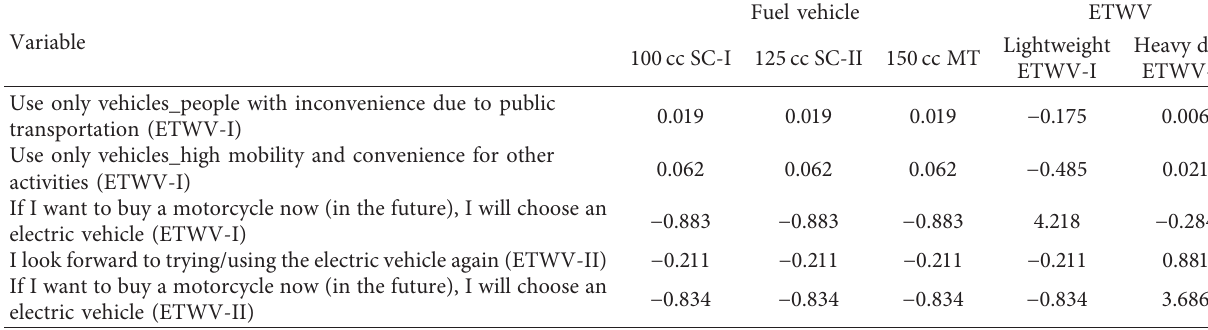
Table 9: Elasticity analysis of the policy promotion